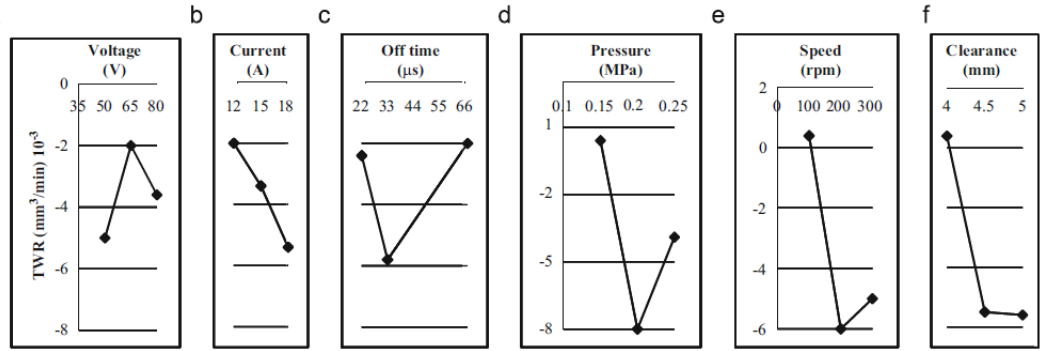
Figure 12. ( a – f ) Main effects of input parameters associated with the tool wear rate (TWR) [174].